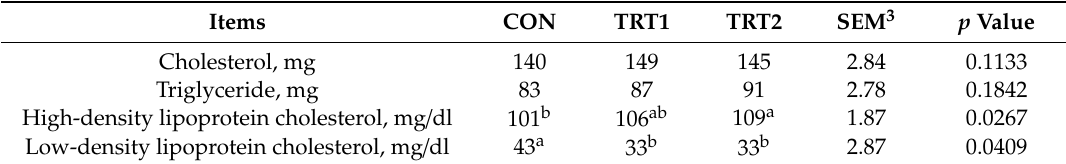
Table 5. The e ff ect of dietary DOL supplementation on blood profiles in broilers † , ‡ .